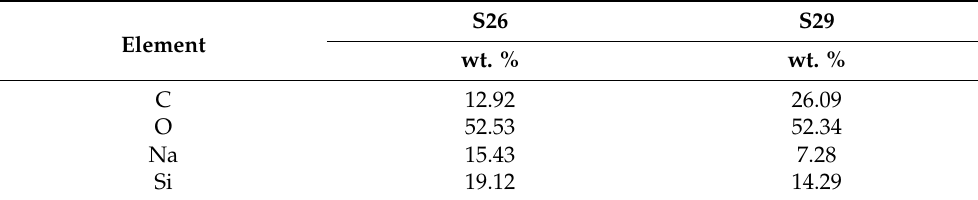
Table 7. EDX results before the fire resistance test.